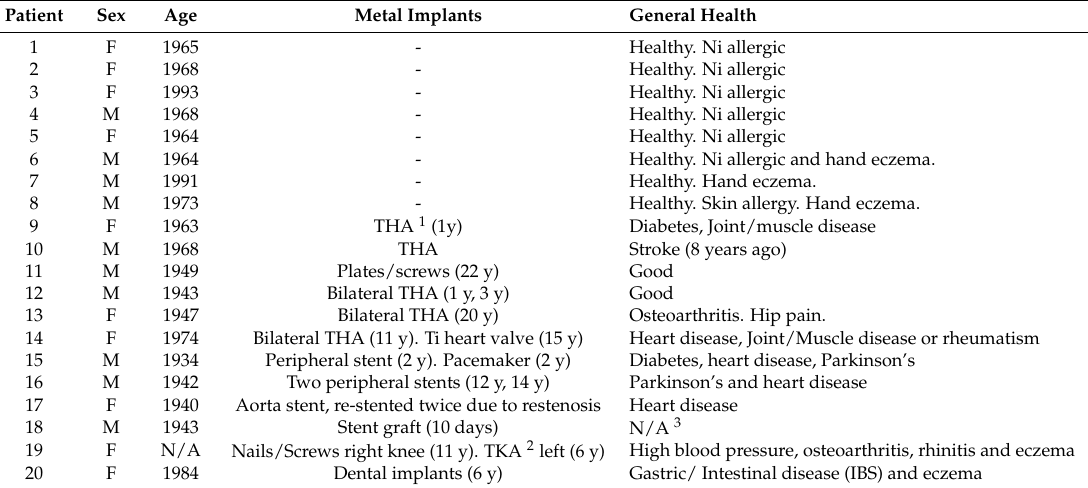
Table 1. Test subject information, implant status, and general